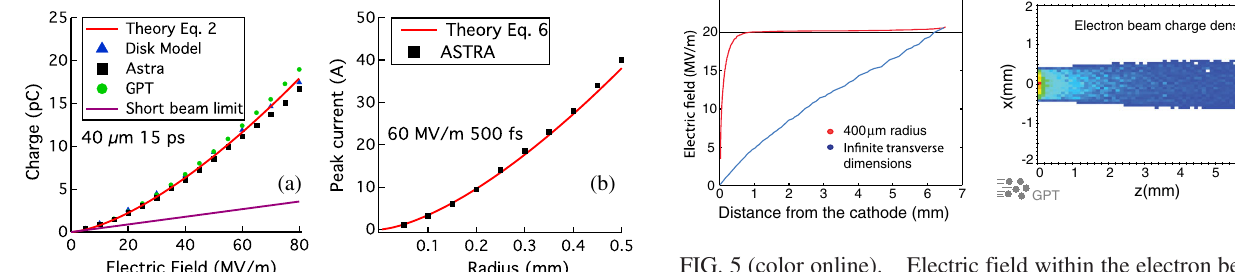
FIG. 5 (color online). Electric field within the electron beam at the end of the laser pulse duration time Δ t for a finite and infinite transverse dimension (left panel) and the relative electron beam FIG. 3 (color online). (a) Emitted charge vs electric field E 0 charge density distribution (right panel) for the finite radius case for a cigar aspect ratio beam, C c ¼ 1 . (b) Peak current vs cathode simulated by GPT. The black line on the left panel shows the level size in the short pancake-beam limit ( E 0 ¼ 60 MV = m, Δ t ¼ 500 fs) and C ¼ 1 [see Eq. (6)]. of the external s